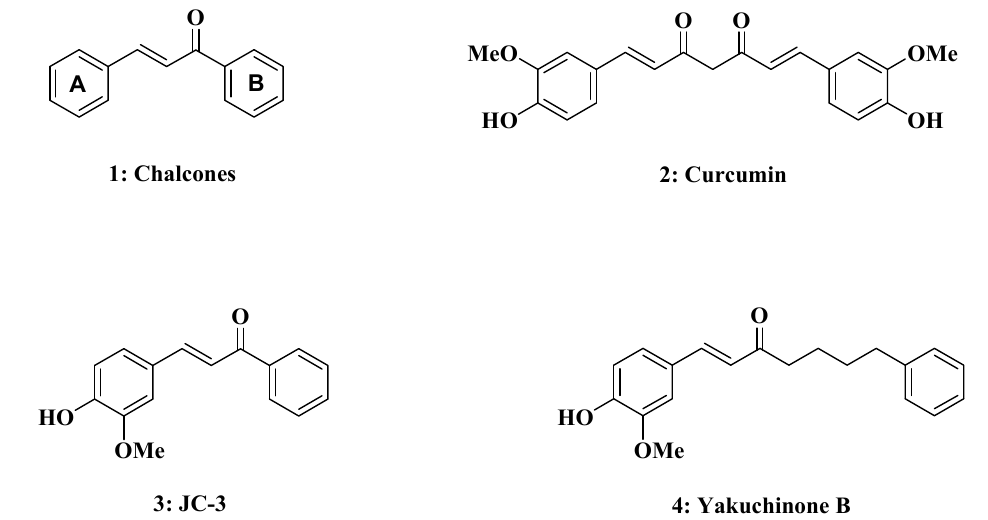
Figure 1. Structures of chalcone 1 , curcumin 2 , JC-3 3 , and yakuchinone B 4 .